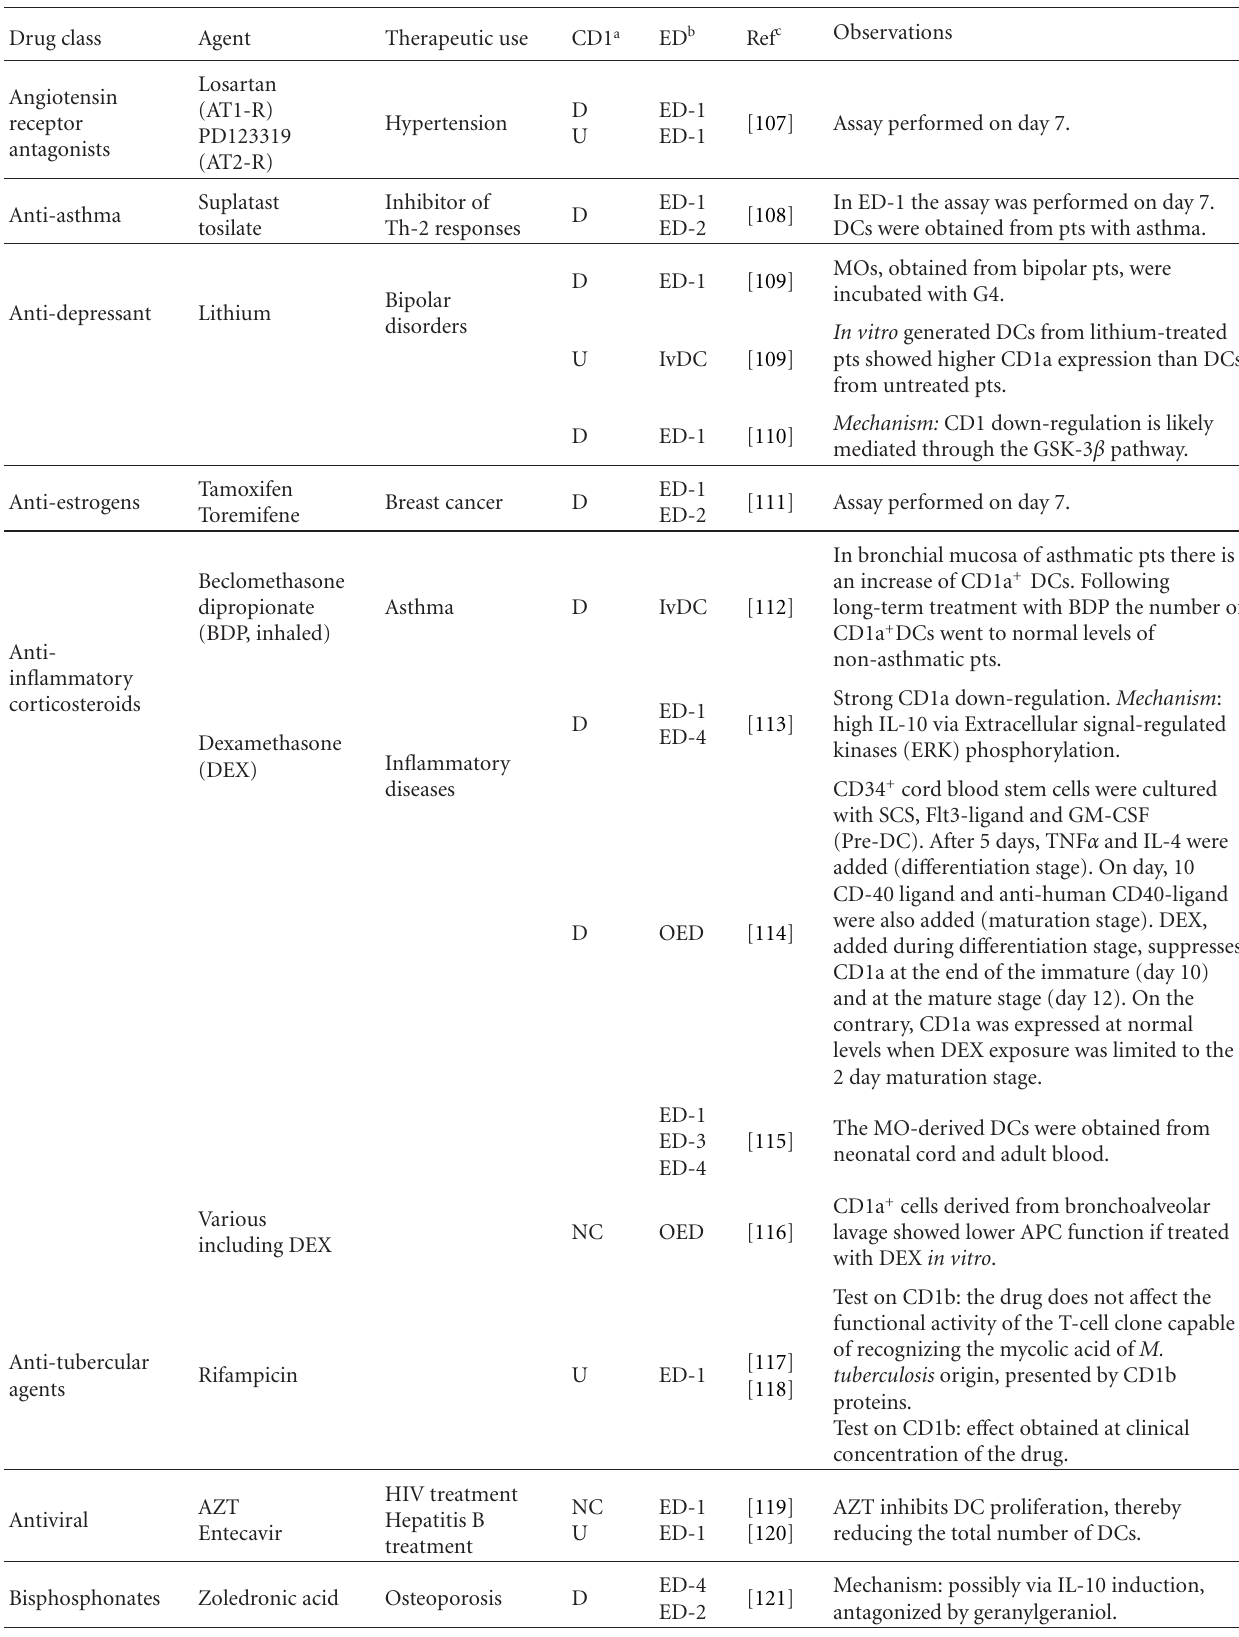
Table 2: Pharmacological modulation of CD1 molecule